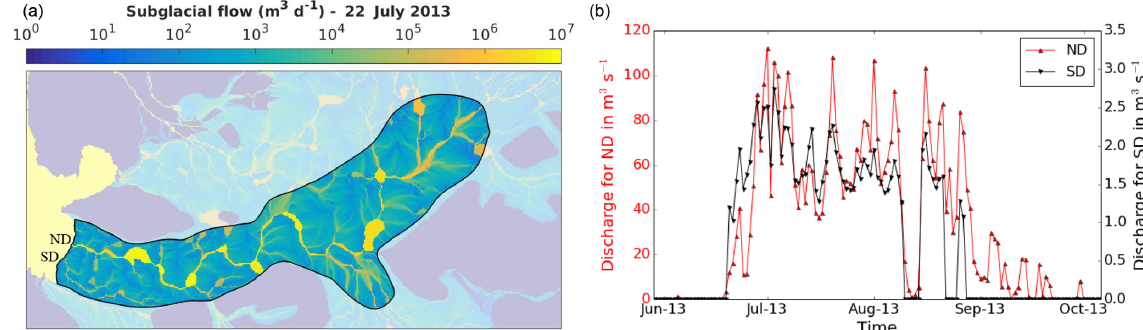
Figure 6. (a) Subglacial flow following the hydraulic potential surface (in m 3 d − 1 ) in logarithmic scale on 22 July 2013. (b) Daily discharge for the northern and southern discharge (ND and SD respectively) during the melting season (data gaps correspond to no discharge).